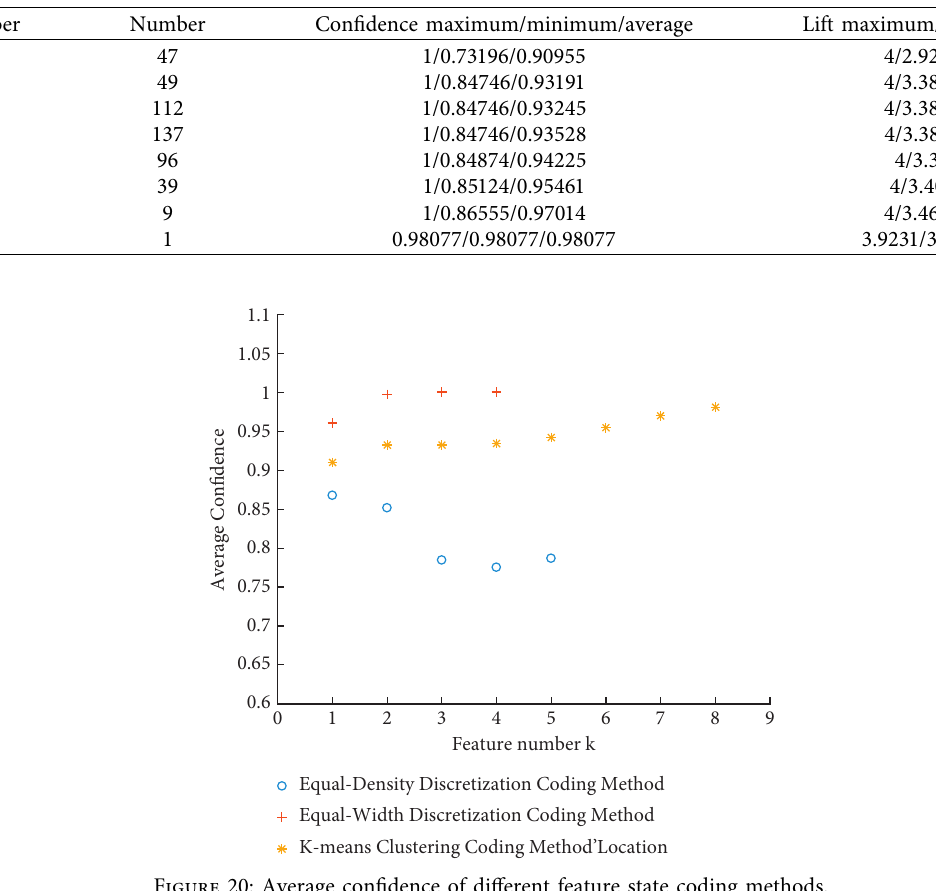
Table 10: Fault diagnosis rule extraction results based on the K -means clustering coding method.